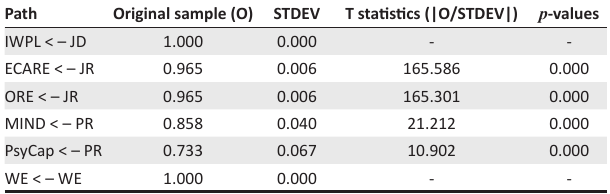
TABLE 4: Outer loadings.